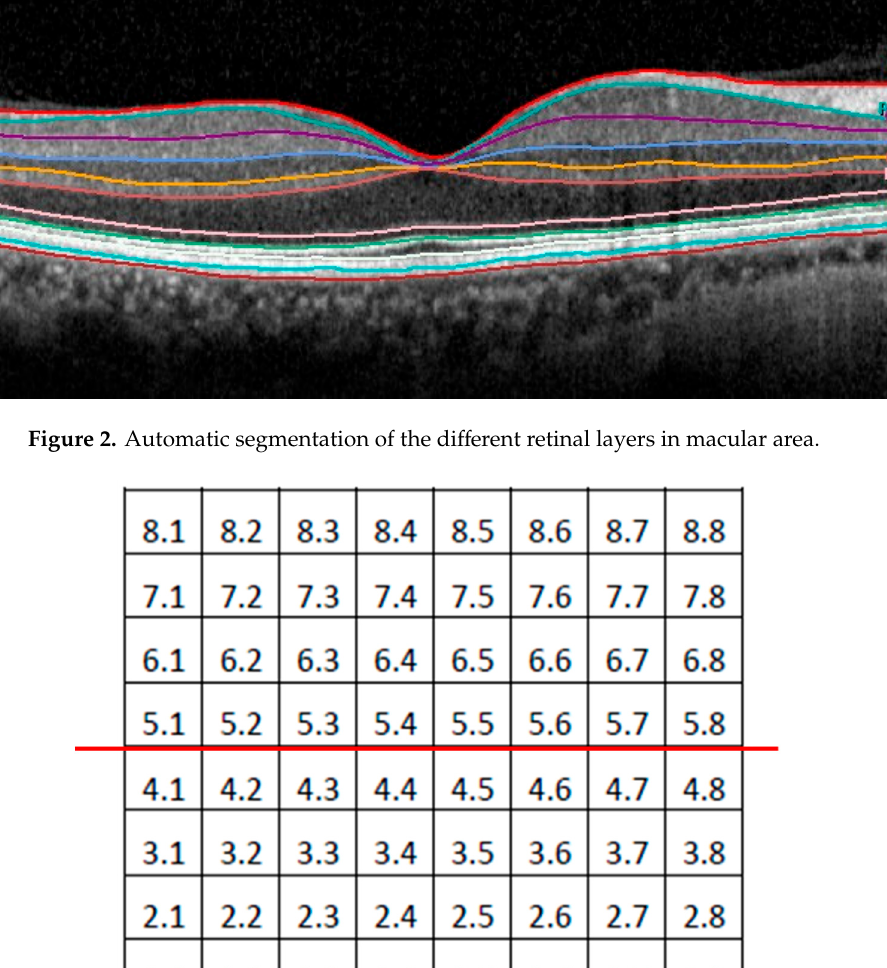
Figure 2. Automatic segmentation of the different retinal layers in macular area.